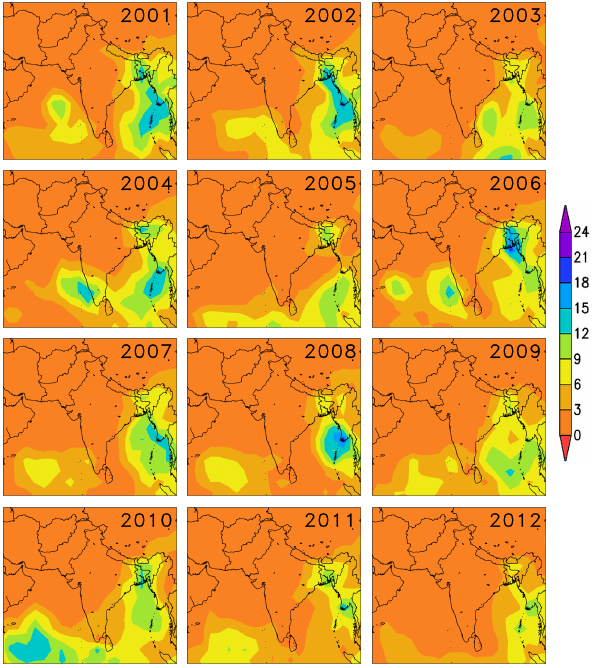
Figure 8. GPCP monthly mean precipitation in May for the years 2001–2012 over the region bounded by 5 to 40 ◦ N and 50 to 100 ◦ E.